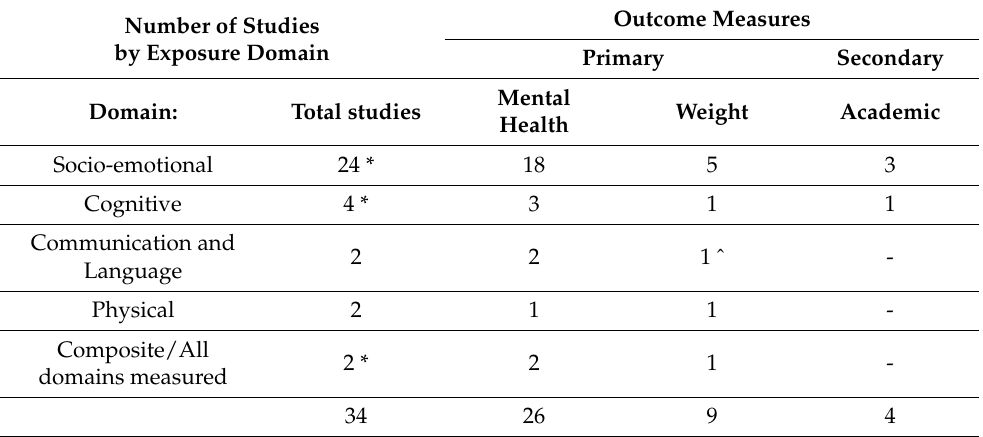
Table 2. Studies by child development domain and adolescent